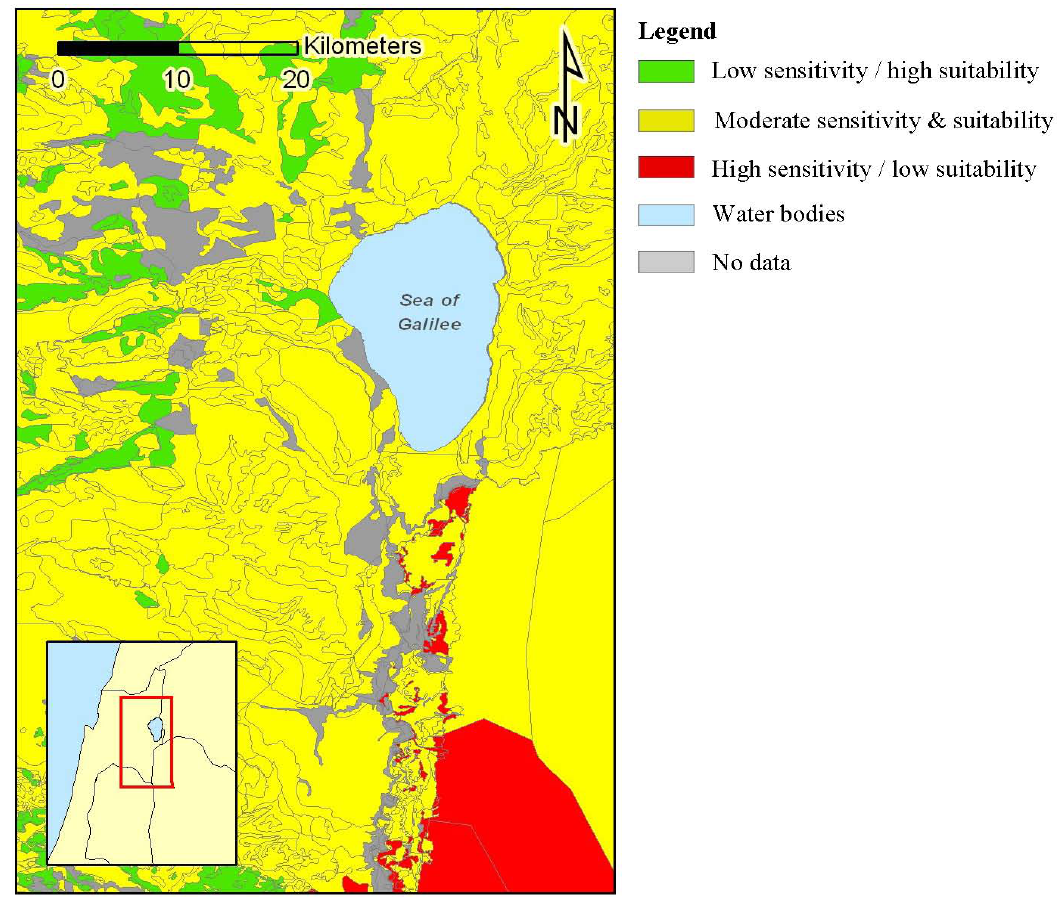
Figure 5. Cut-out of the assessment map visualizing sensitivity D: Sensitivity towards the mobilization of boron (scale 1: